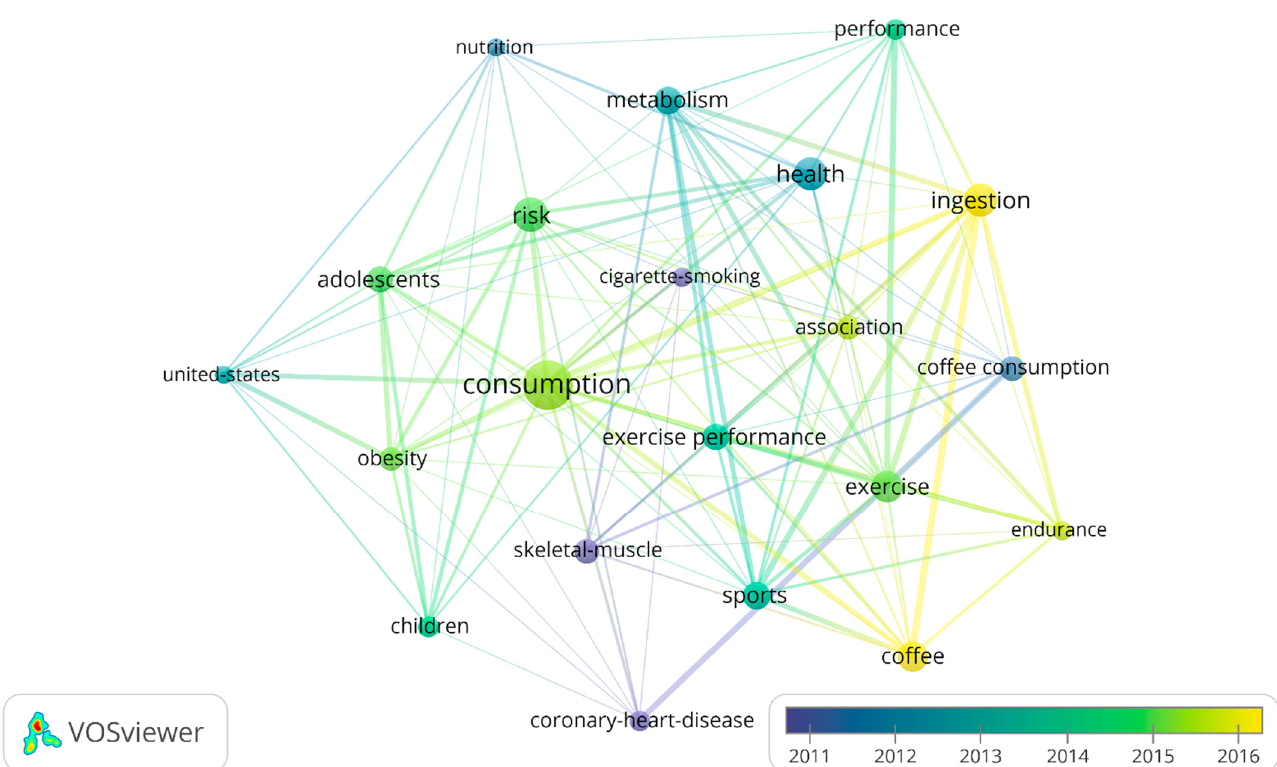
Figure 8. Temporary author keywords graph.